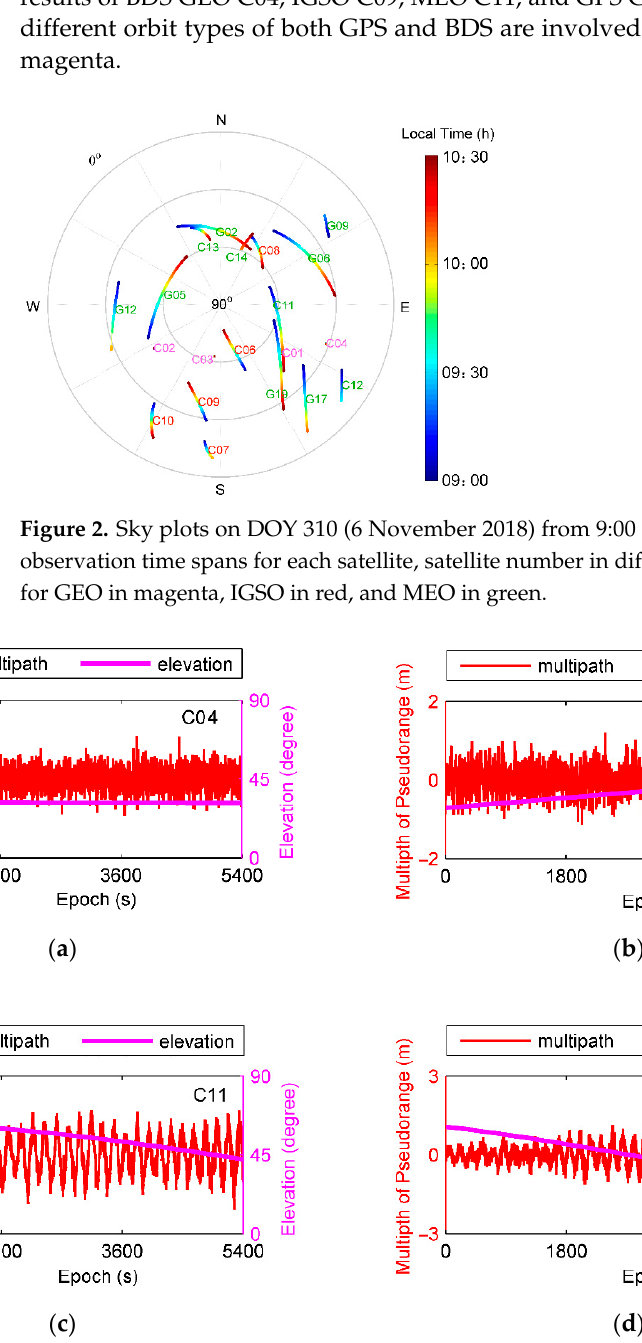
Figure 1. Data collecting site on DOY 310–321, 2018.